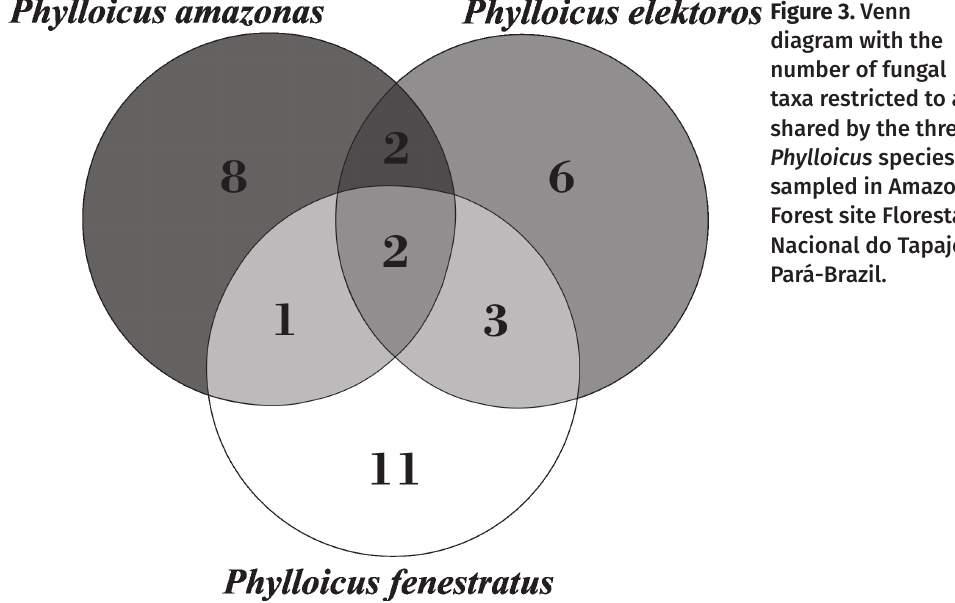
Figure 3. Venn diagram with the number of fungal taxa restricted to and shared by the three Phylloicus species sampled in Amazon Forest site Floresta Nacional do Tapajós,